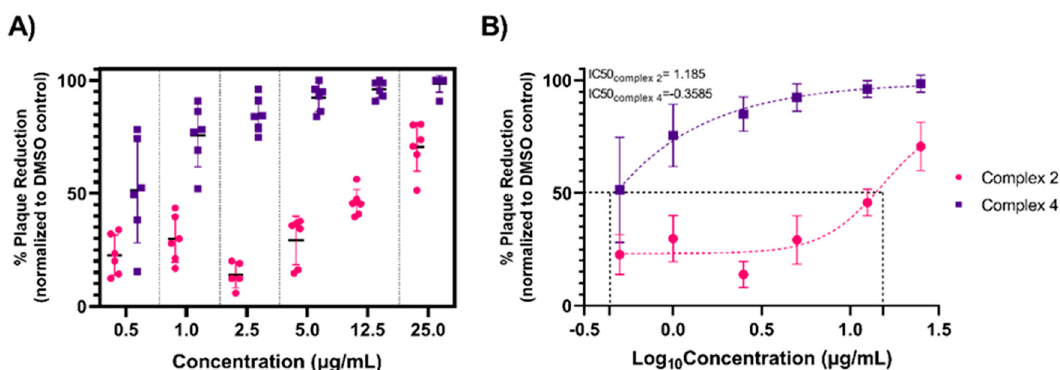
Figure 3. Organometallic Complex 4 shows consistent and robust antiviral activity at low concentrations. ( A ) Complexes 2 and 4 were inoculated with 200 PFU of SARS-CoV-2 at concentrations ranging from 0.5-25 µ g/mL and incubated for 3 h at 37 ◦ C to determine the threshold of antiviral activity. Following incubation, complex–virus mixtures were added to Vero E6 cells for a 1 h adsorption period. Infectious SARS-CoV-2 titers were quantified via plaque assay and data are reported as percent plaque reduction compared to a DMSO-virus control. Data were analyzed in ( B ) as a dose-response curve with reported IC50 in Log 10 Concentration. Data are shown from two biological replicates conducted in triplicate per concentration. Bars represent the mean and error bars represent the standard